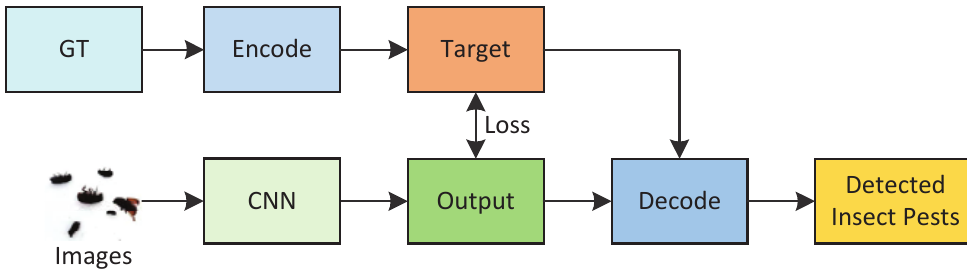
Figure 1. Flow chart of one-stage